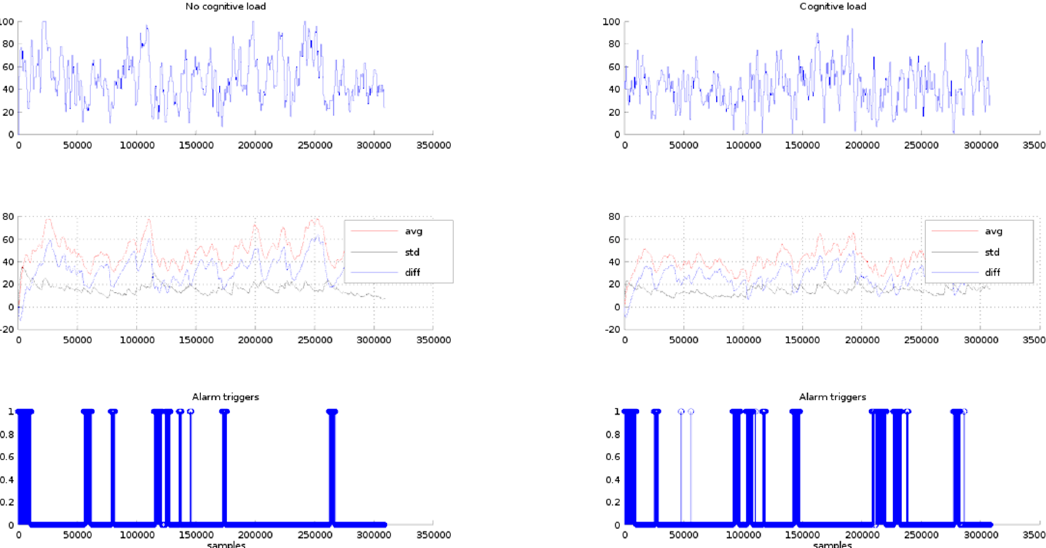
Figure 13. Row 1, P1 EEG signals for the no cognitive load and cognitive load. Row 2, average, standard deviation and difference of the EEG signal values. Row 3, alarm triggers for difference values less than 20 units.